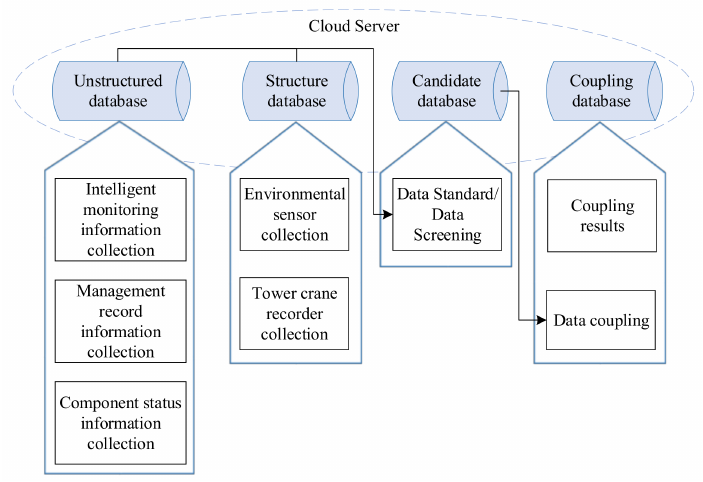
Figure 4. Data storage structure in the IoT system with a self-organizing Wi-Fi